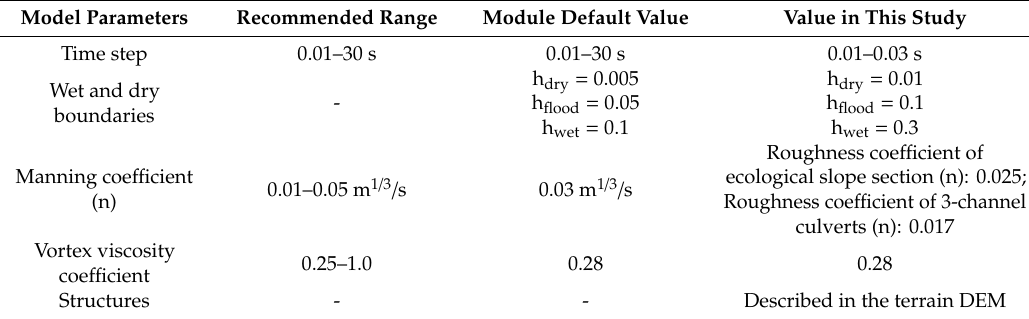
Table 1. Model parameters table [31].